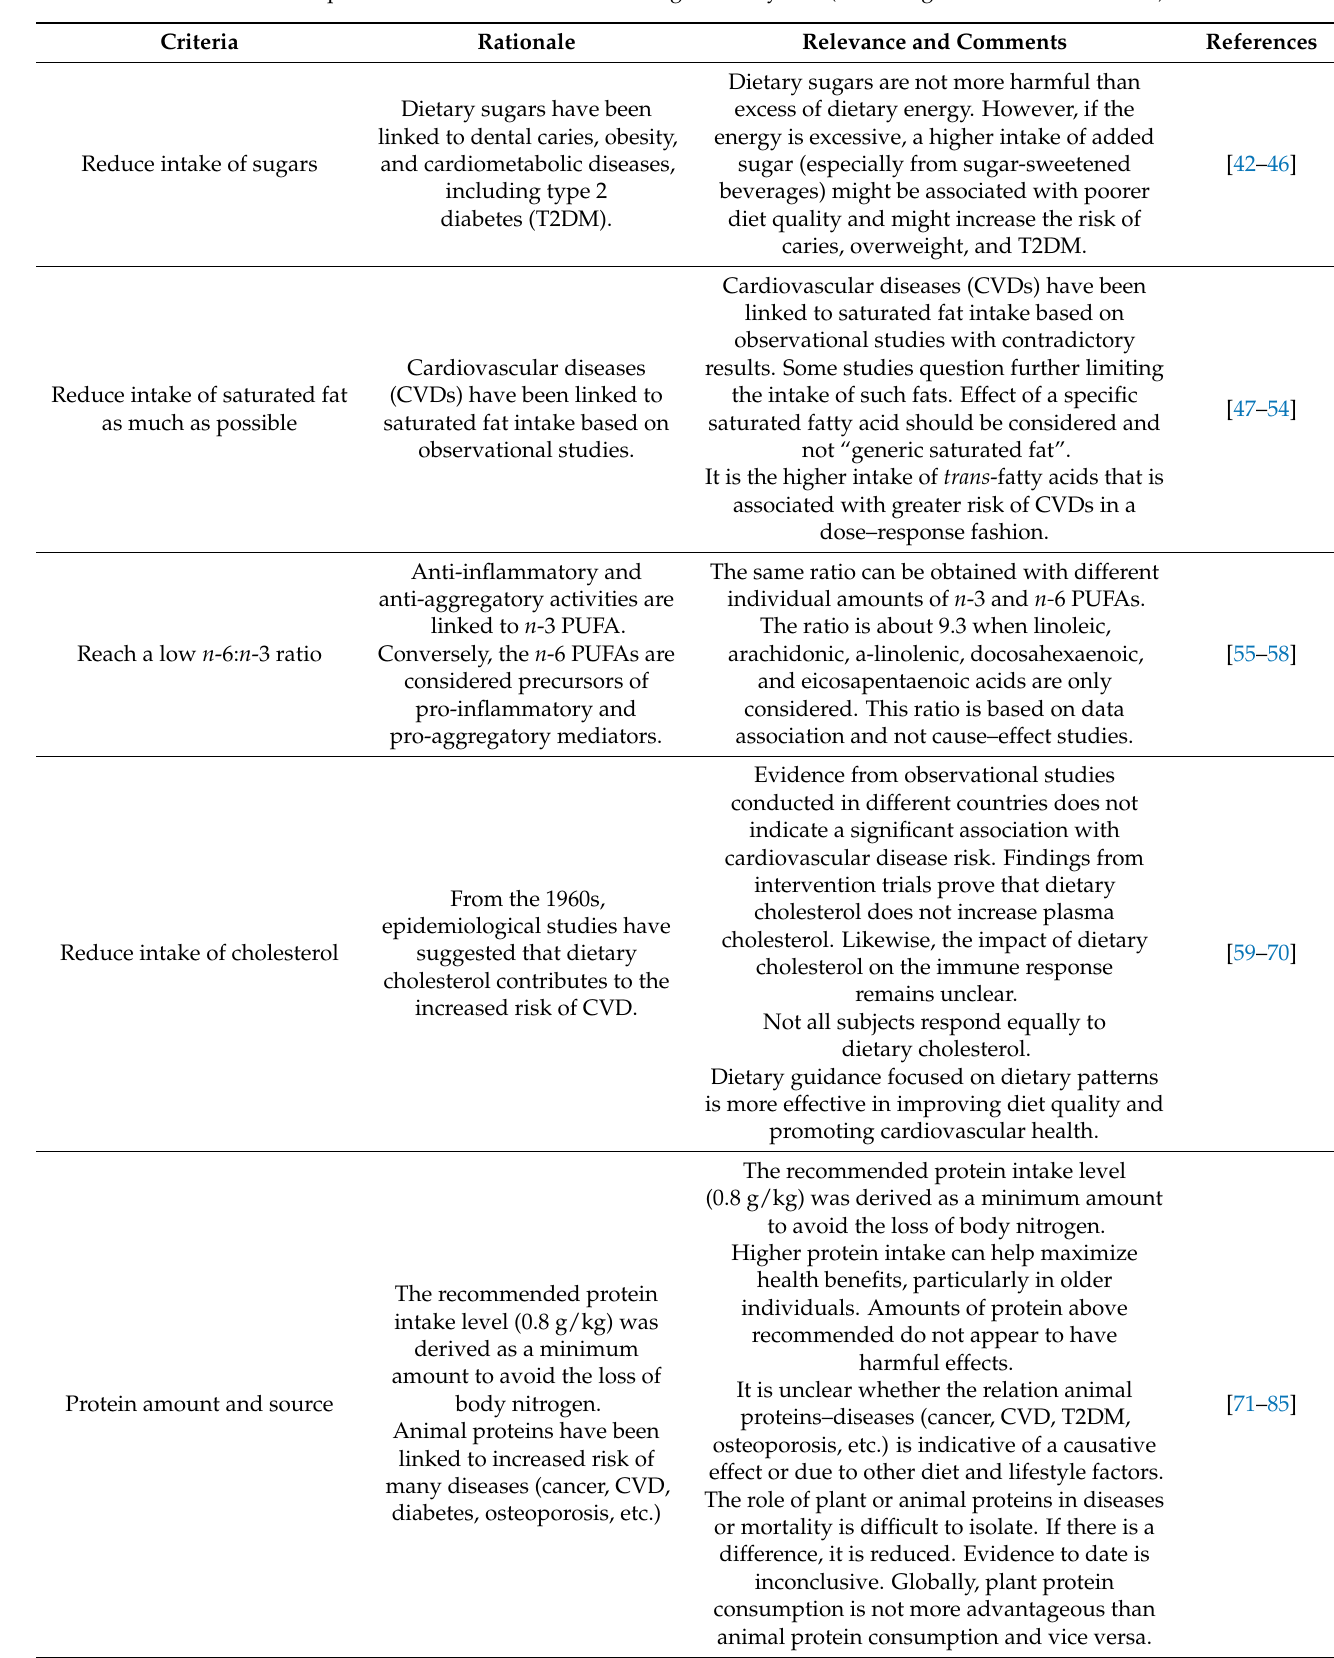
Table 2. Accepted nutritional criteria for defining a healthy diet (according to mainstream science)